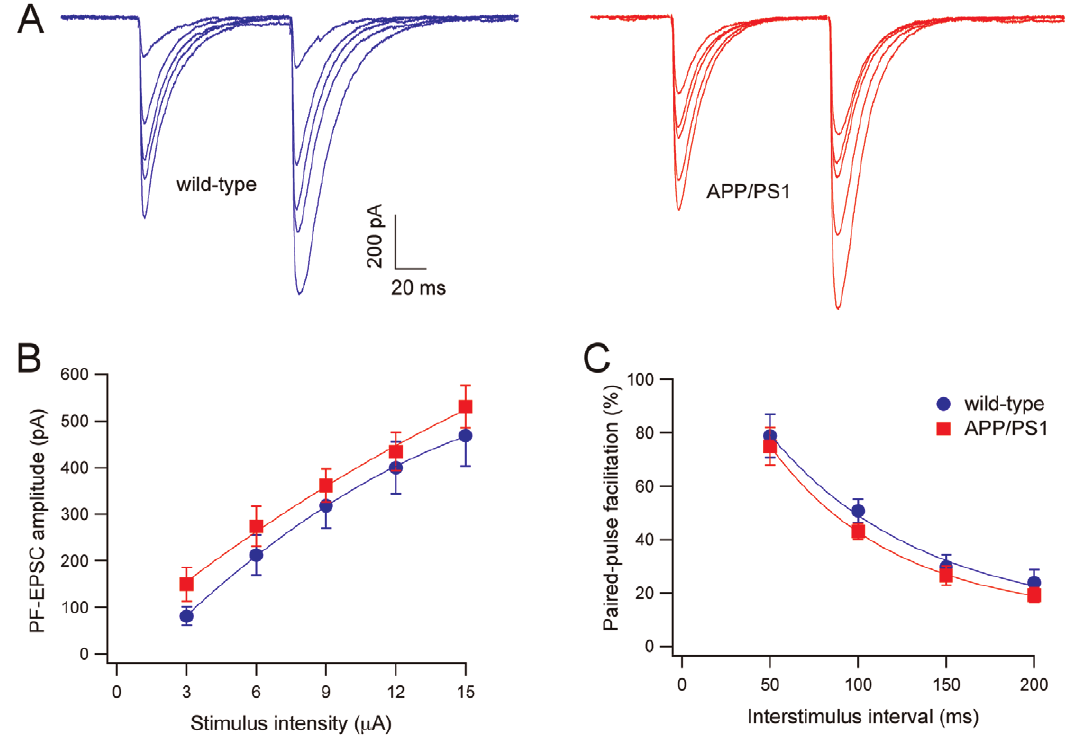
Figure 9. PF-EPSCs in wild-type and APP/PS1 PCs. ( A ) Representative traces of PF-EPSCs evoked by paired-pulse stimulation with an interpulse interval of 100 ms in wild-type (blue) and APP/PS1 (red) mice. Five traces obtained with stimulus strength from 3 to 15 m A are superimposed. ( B ) Amplitudes of PF-EPSCs are plotted as a function of stimulus intensity for wild-type (blue circles, n=14) and APP/PS1 (red squares, n=17) PCs. ( C ) Time course of paired-pulse facilitation of PF-EPSC in wild-type (blue circles, n=17) and APP/PSl mice (red squares, n=14). The facilitation is expressed as the percentage of the second EPSC relative to the first one (mean 6 SEM) and is plotted as a function of interstimulus interval.